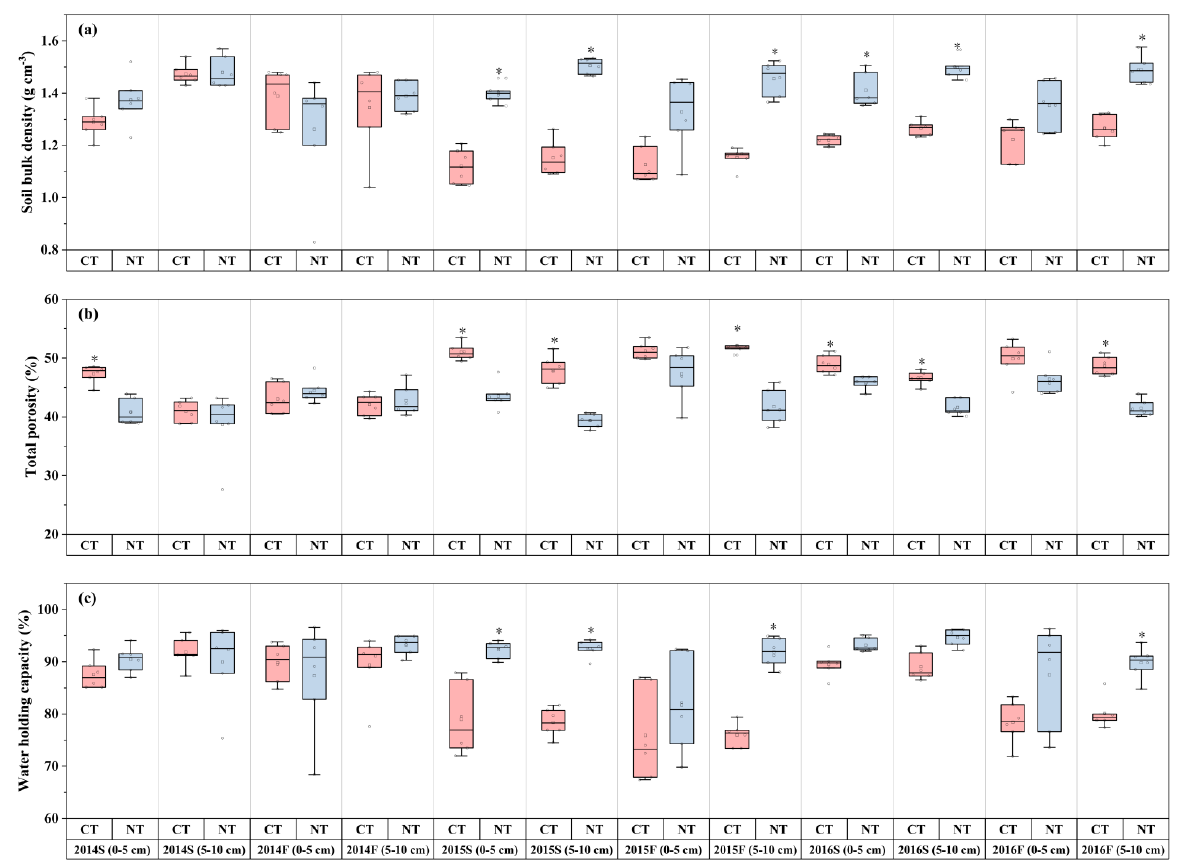
Figure 2. Soil bulk density ( a ), total porosity ( b ), and water holding capacity ( c ) for CT and NT at 0–5 cm and 5–10 cm depths at spring (S) and fall (F) of 2014-2016. * p < 0.05.